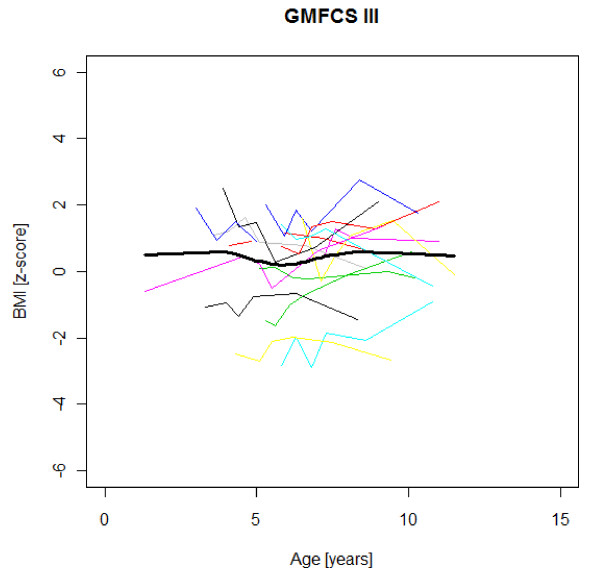
BMI z-scores in GMFCS III. BMI z-score at different age in 15 children with CP spastic diplegia, GMFCS III. Their mean z-score development with age is shown in black.